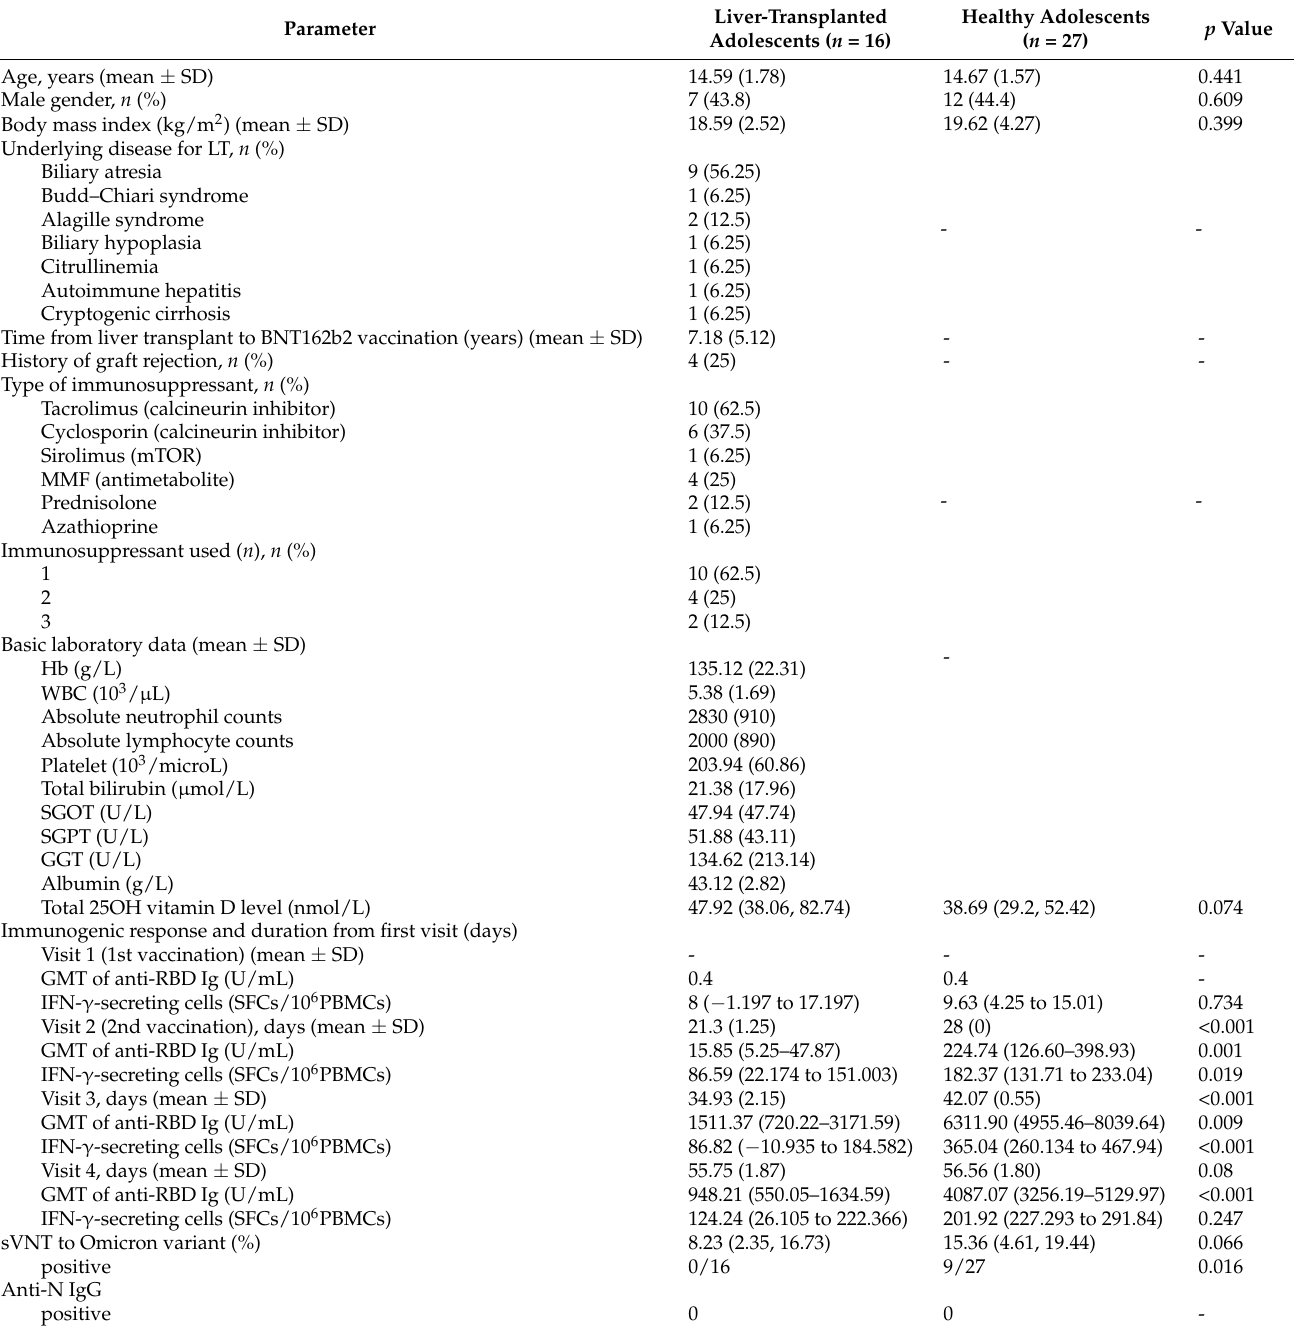
Table 1. Participant characteristics and immunologic response to BNT162b2 vaccination between liver-transplanted adolescents and healthy